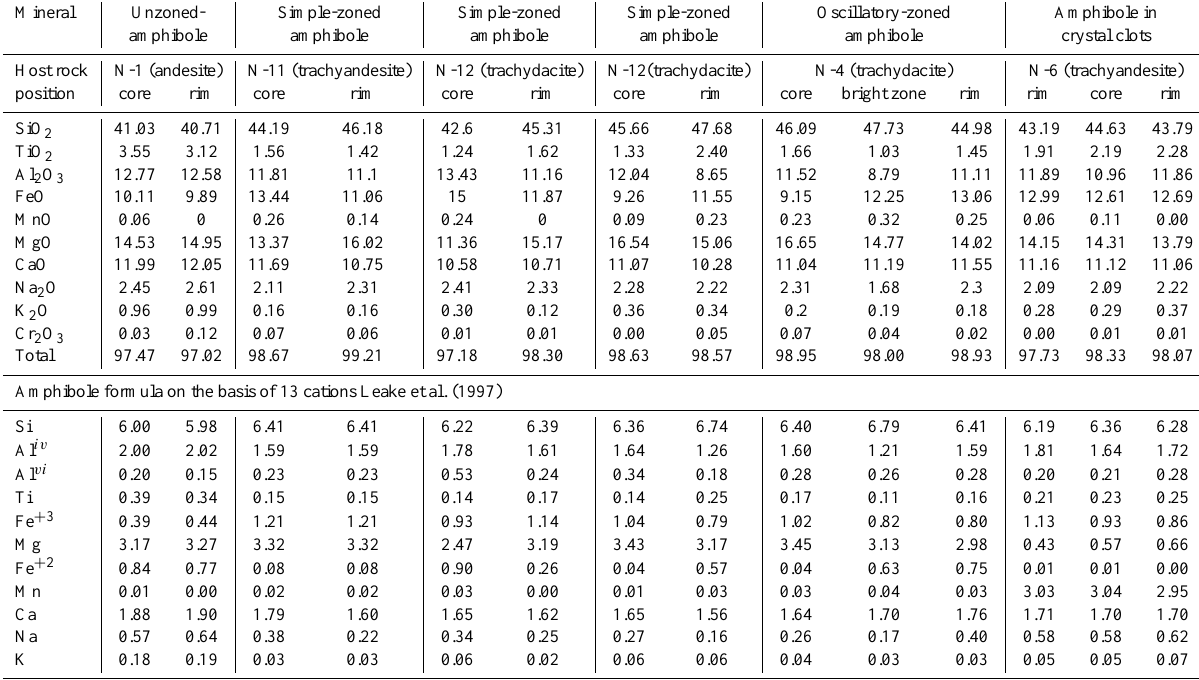
Table 2. Representative compositions of amphiboles from post-ophiolite rocks in the Sabzevar zone. Mineral Unzoned- Simple-zoned Simple-zoned Simple-zoned Oscillatory-zoned Amphibole in amphibole amphibole amphibole amphibole amphibole crystal clots Host rock N-1 (andesite) N-11 (trachyandesite)